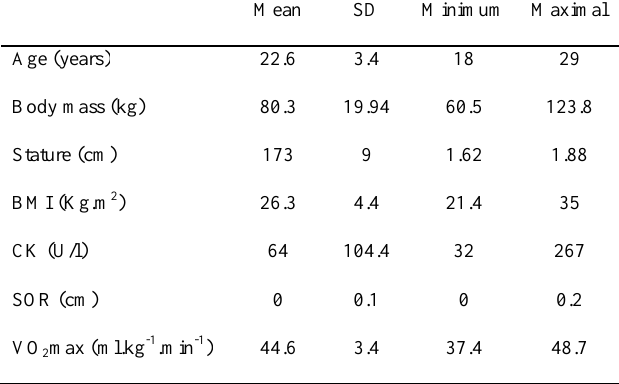
Table 1. Anthropometric characteristics and baseline values of the indirect markers of muscle damage. BMI - Body mass index; CK = Creatine kinase; SOR = Soreness; VO = Maximum oxygen 2max